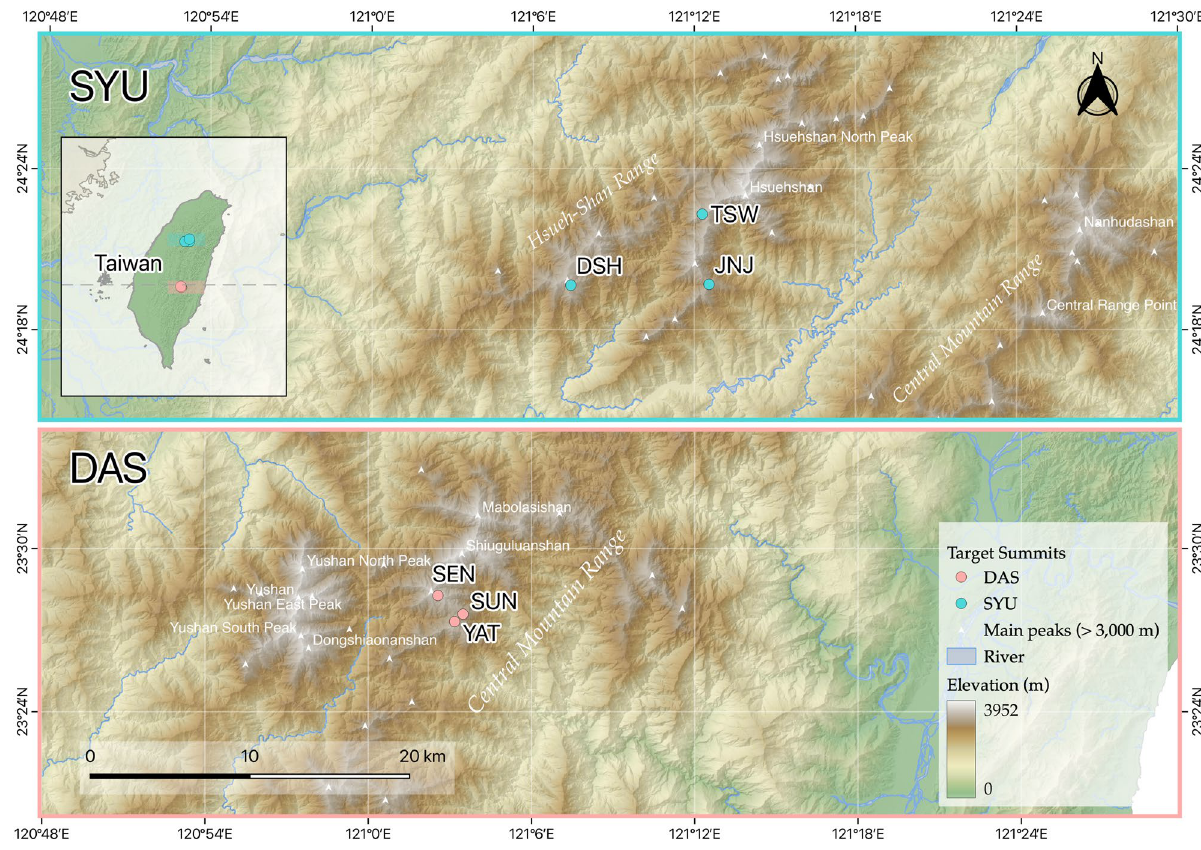
Figure 6. The location of long-term monitoring summits in alpine environments of Taiwan. The summits of Dashueiku Mountain (DAS) region: SEN, YAT and SEN; the Syue Mountain (SYU) region: TSW, DSH and JNJ). The map was drawn by QGIS (version 3.24; URL: https:// qgis. org).